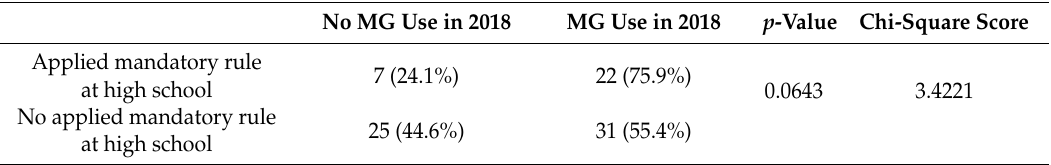
Table 7. E ff ect of the mandatory rule at high school on adult wearing